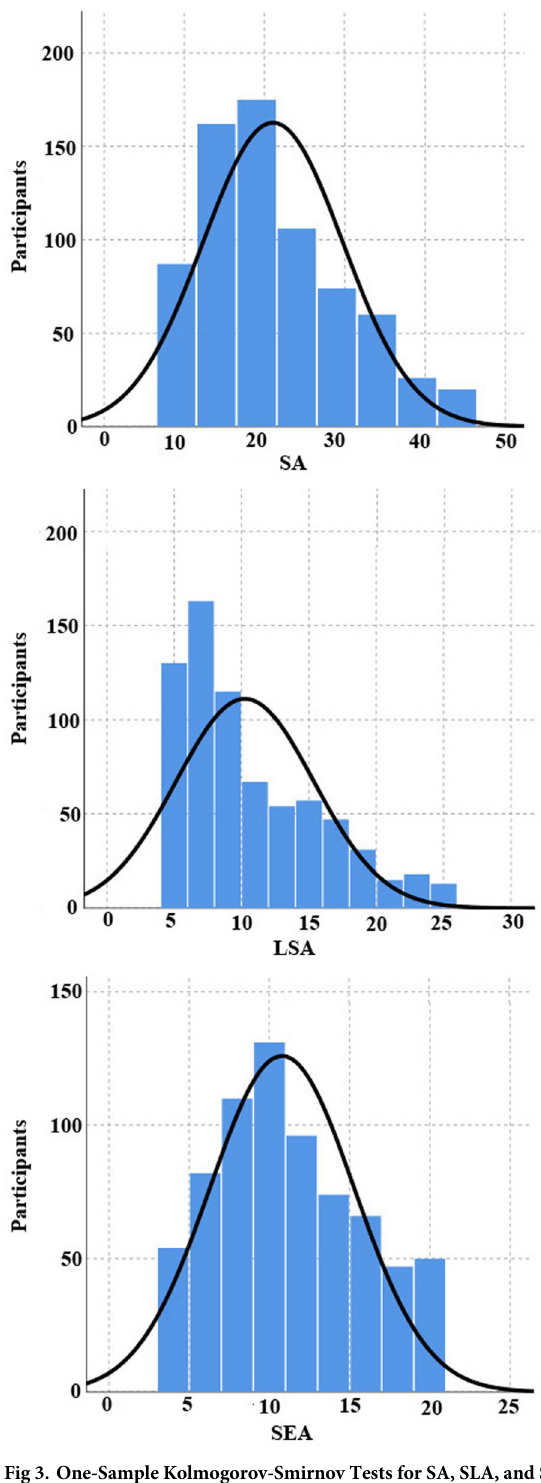
Fig 3. One-Sample Kolmogorov-Smirnov Tests for SA, SLA, and SEA in Study 1. SA = science anxiety; LSA = learning science anxiety; SEA = science evaluation anxiety.